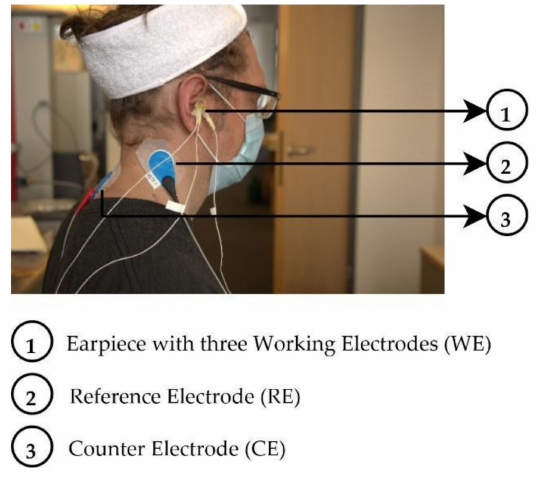
Figure 3. Impedance measurement setup on a subject. Electrodes on earpieces are working elec- trodes (WE), counter electrode (CE) is at inion, and reference electrode (RE) is between WE and CE, equidistant from